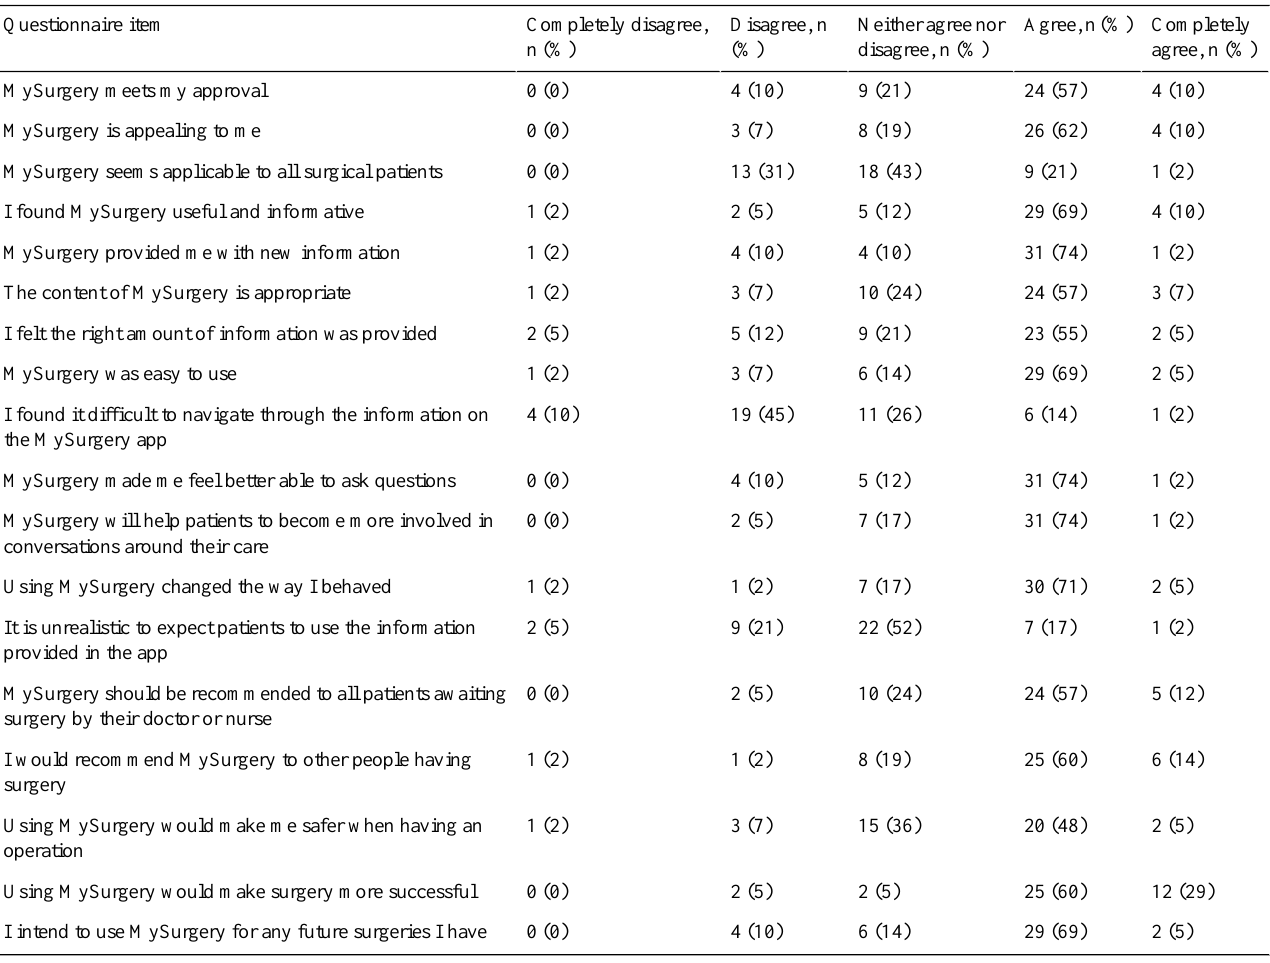
Table 2. Summary of survey responses for the 18 items relating to perceptions of MySurgery (N=41).